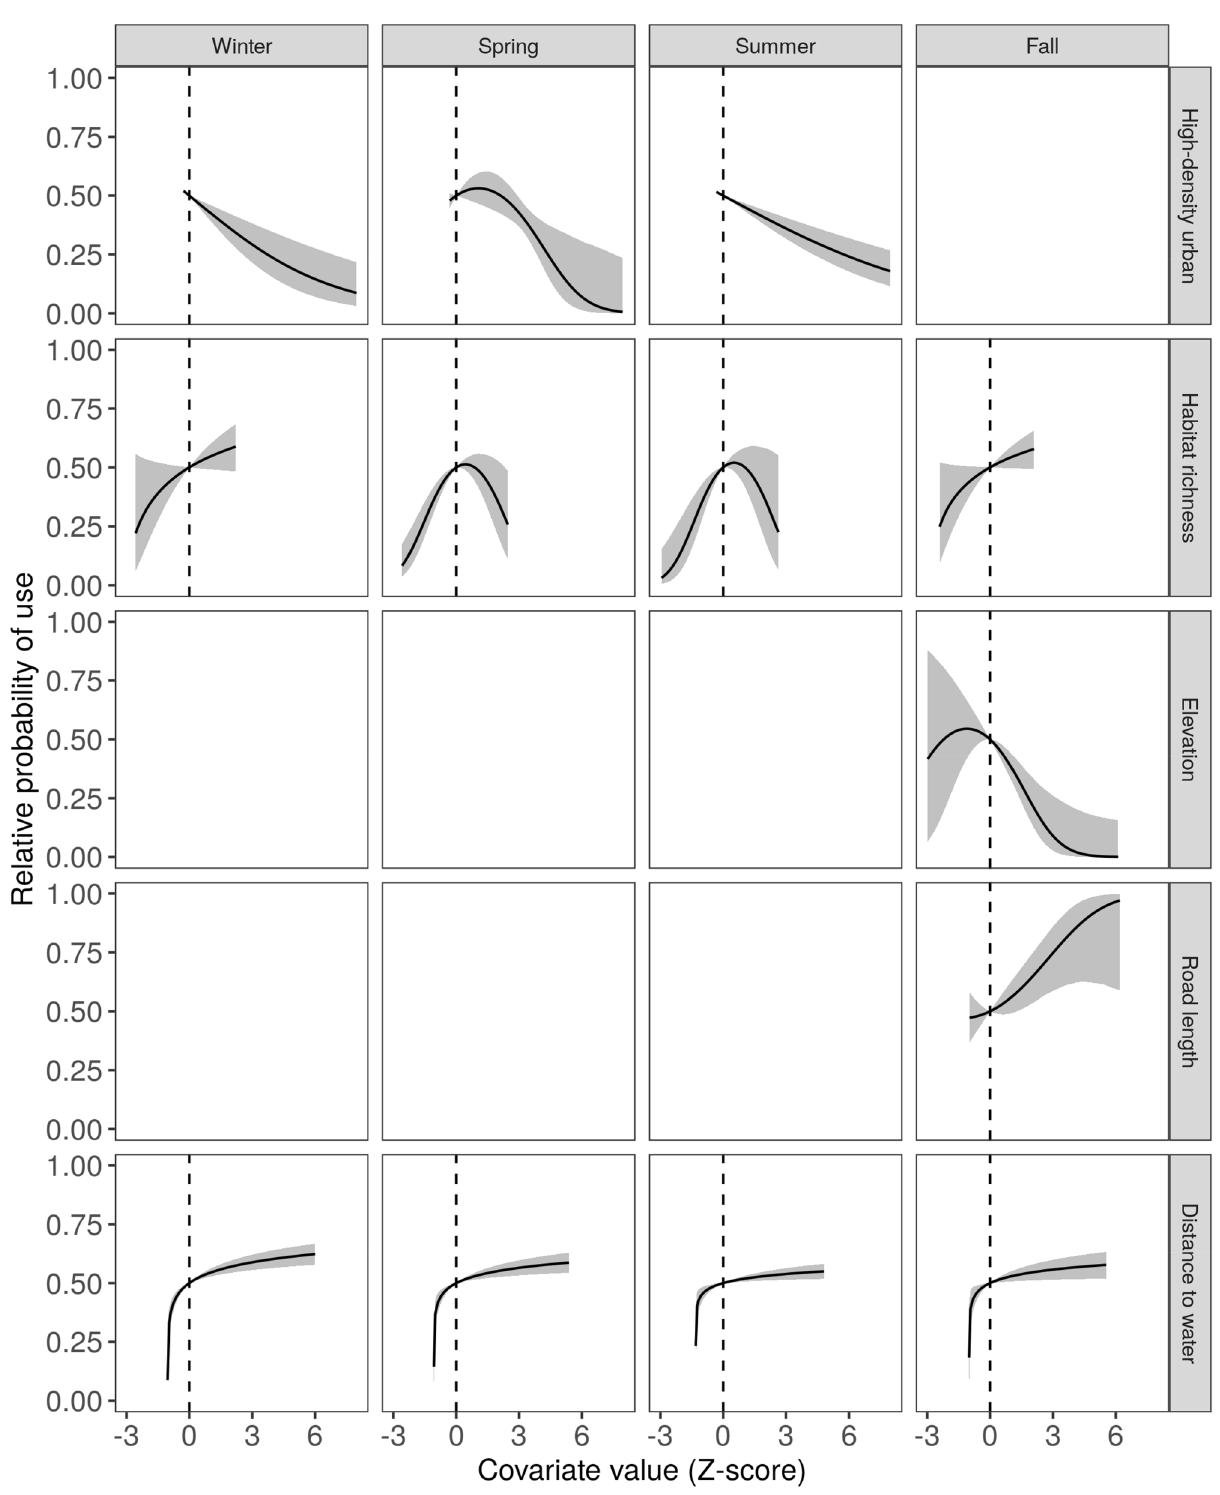
Figure 3. Relative probability of black vulture roost site resource selection as a function of covariates (rows) included in the top-ranked model each season (columns). The relative probability represents the probability a vulture would select a site with the given focal covariate value over a second site where the focal covariate value is equal to the mean of that covariate (represented by the dotted line), with all other covariates also held at their mean values. The shaded area represents a 95% confidence envelope around the relative probability. Blank panels in the figure indicate that the corresponding covariate was not in the best model for that